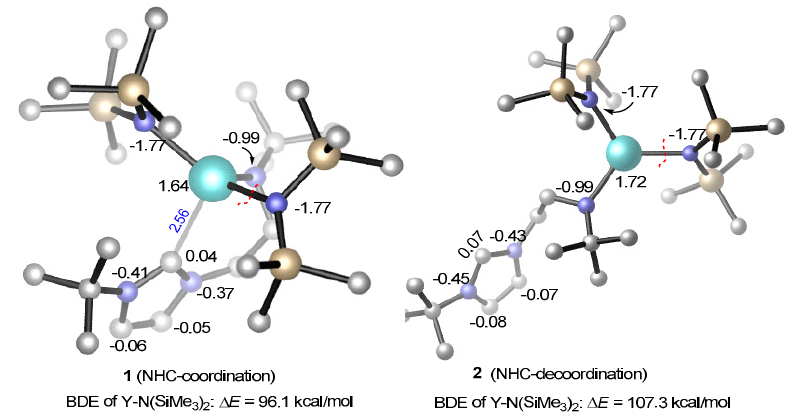
Figure 3. The bond dissociation energy of Y–N(SiMe 3 ) 2 in the coordination and de-coordination of the N -heterocyclic carbine (NHC) moiety. NBO (Natural bond orbital) atomic charges are given in black. All H atoms are omitted for clarity.